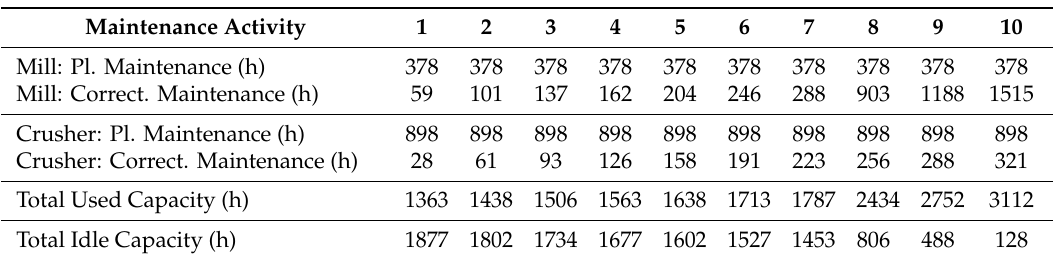
Table 5. Time consumed by maintenance activities and equipment along the planning horizon (year 1 to year